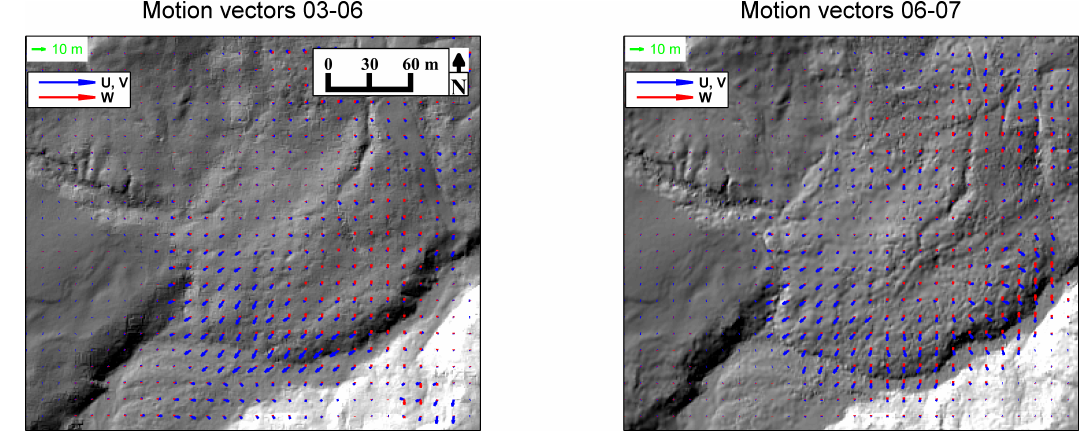
Motion vectors at the toe of the landslide from 2003 to 2007, Blue: horizontal movement; red: change in elevation. Red arrows pointing towards the north: upwards motion.